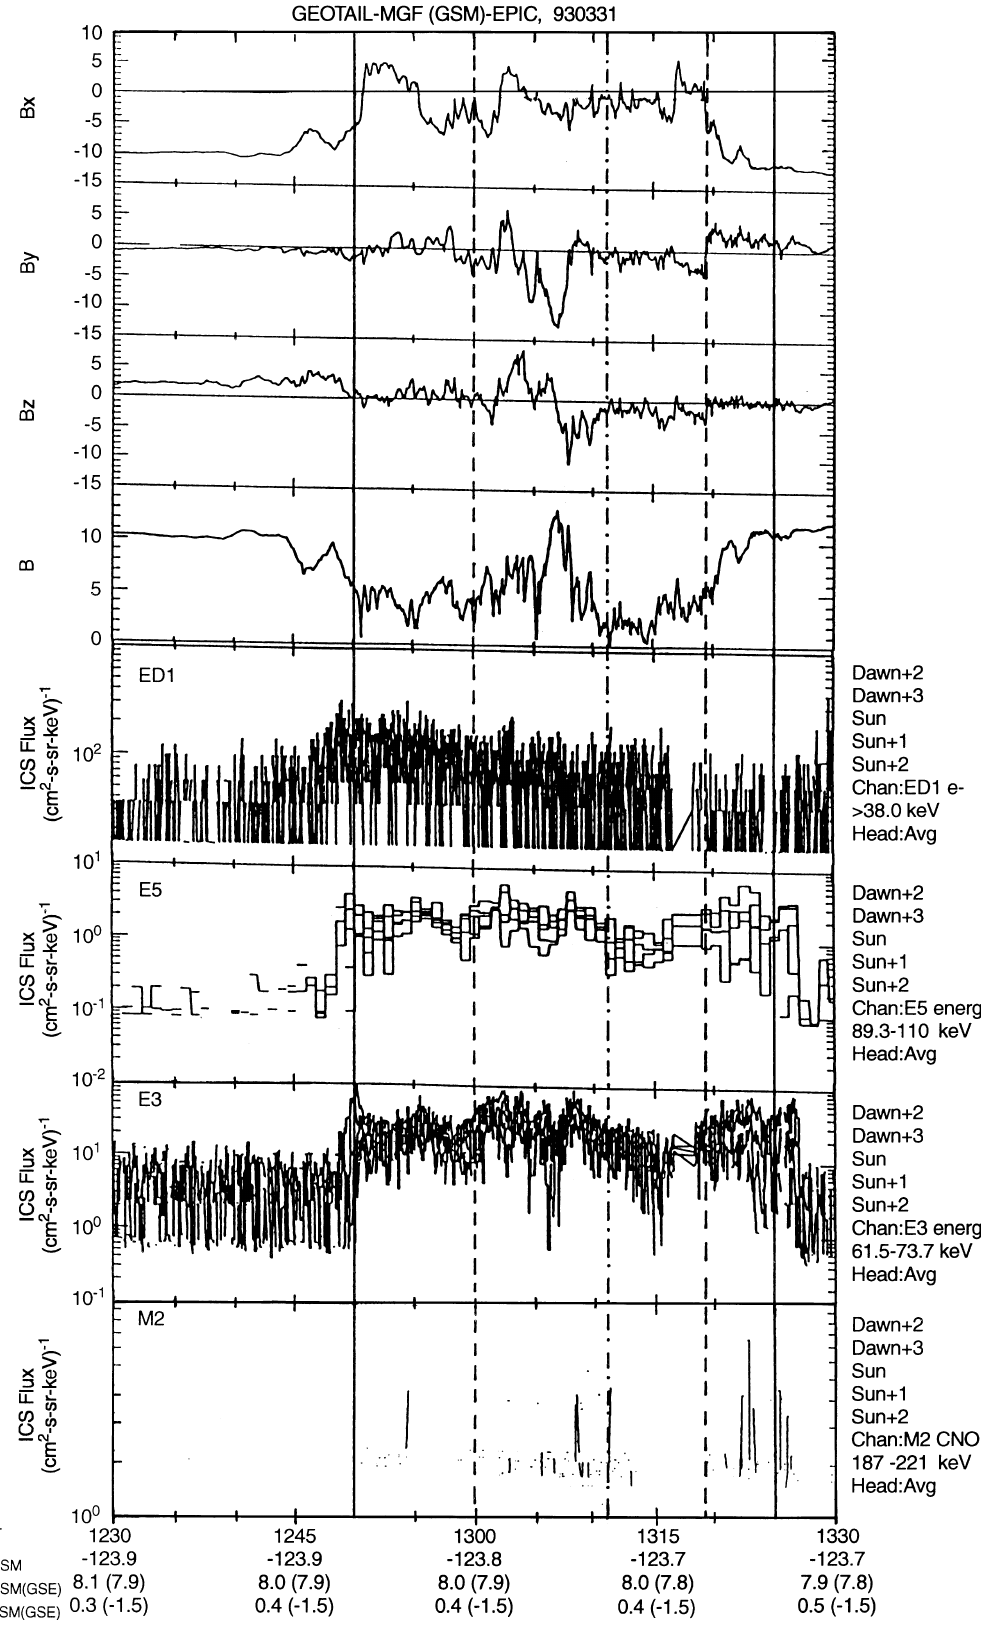
respectively. The two dashed vertical lines indicate the start (1300 UT) and the end times (1319 UT) of the convection interval. The Earthward edge of the bipolar B z signature detected at 1311 UT is marked by the vertical dashed-dotted